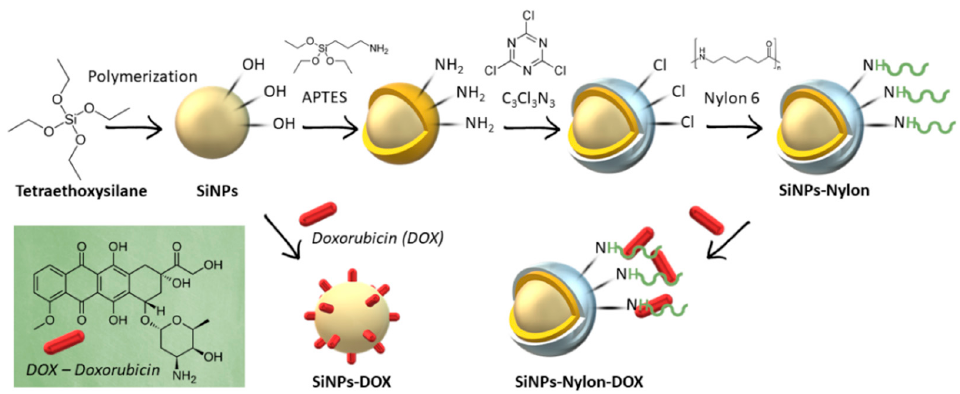
Figure 2. Synthesis of nylon 6-coated SiNPs (SiNPs-Nylon) and DOX-loaded SiNPs (SiNPs-DOX) or SiNPs-Nylon (SiNPs-Nylon-DOX). APTES–(3-aminopropyl) triethoxysilane; С 3 Cl 3 N 3 –2,4,6-Tri- chloro-1,3,5-triazine ( с yanuric chloride).